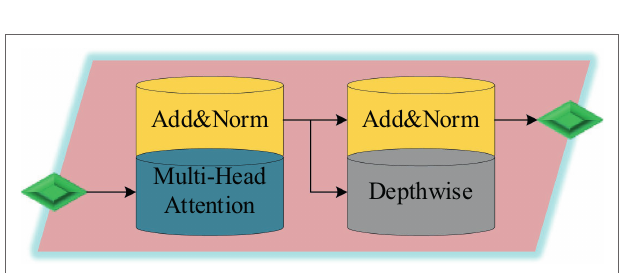
FIGURE 4 | DSC-Transformer model.